Question: Describe this figure in one sentence.
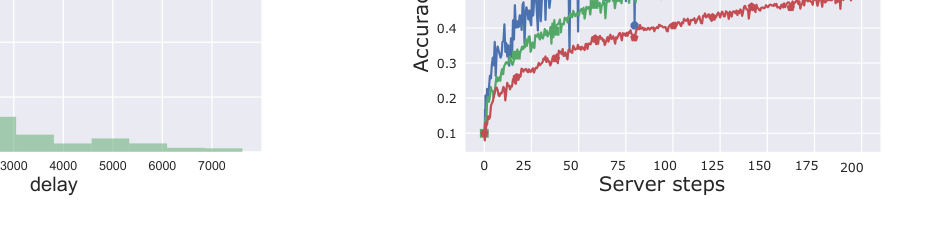
Answer: Accuracy on validation dataset on central server, for CIFAR-10 classification task.